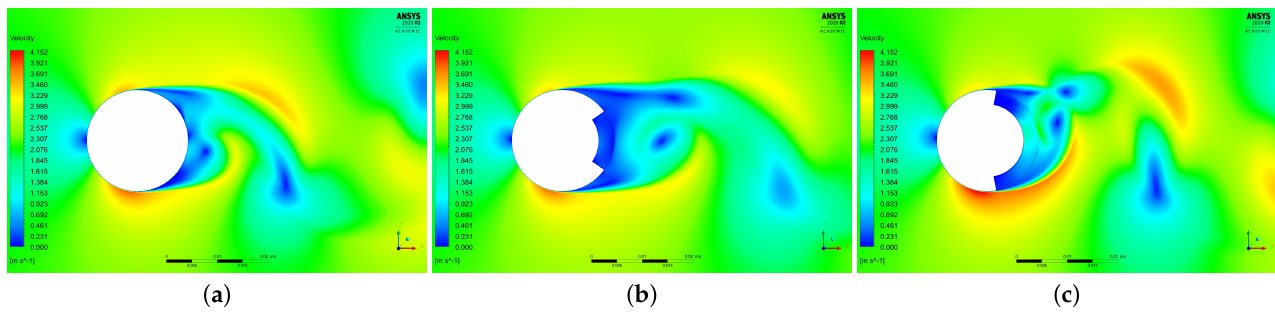
Figure 11. Contours of velocity at Re = 4.2 × 10 4 . ( a ) Smooth cylinder. ( b ) β = 70 ◦ (thickness t / D = 14.3% and a porosity of 20 PPI). ( c ) β = 160 ◦ (thickness t / D = 14.3% and a porosity of 20